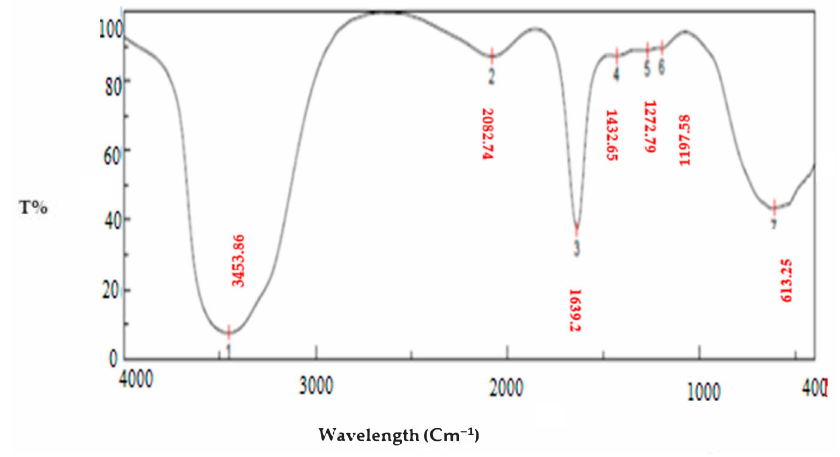
Figure 4. FTIR spectroscopy of the Au-cellulose nanocomposite